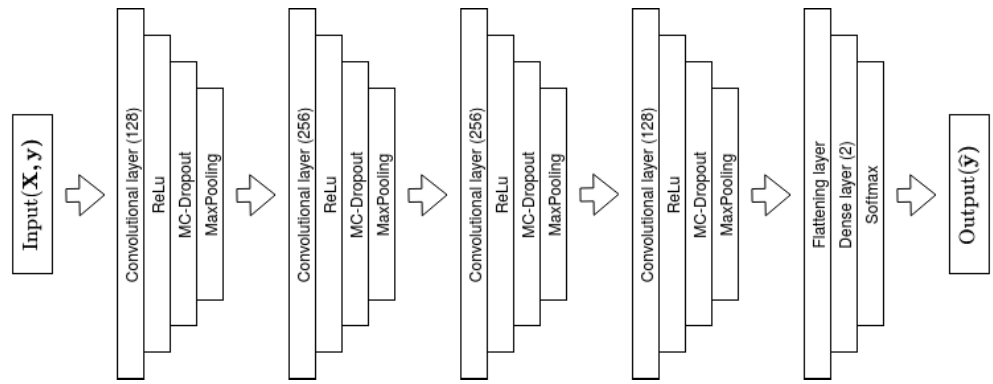
Figure 2. Illustration of the Bayesian Convolutional Neural Network Model